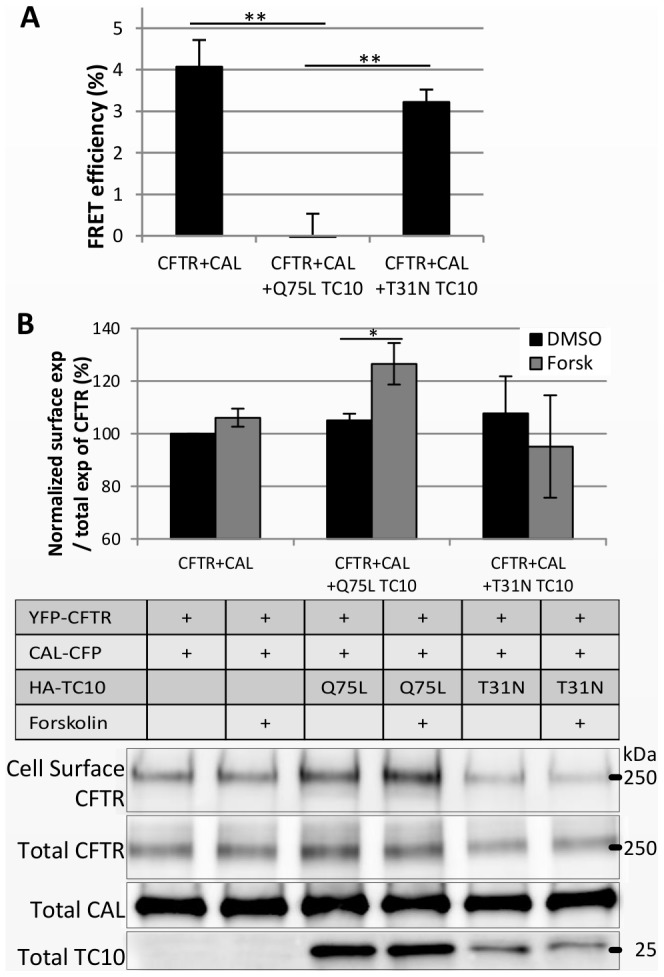
Active TC10 enhances CFTR expression at the cell surface, and this effect is impeded by highly overexpressed CAL HeLa cells were transfected with 1.5 µg of YFP-CFTR plus 0.5 µg (A) or 1.5 µg (B) of CAL-CFP expression vector without HA-TC10, with HA-Q75L TC10, or with HA-T31N TC10, as indicated.(A) The FRET efficiency of CAL and CFTR was reduced by a constitutively active mutant of TC10 (Q75L TC10) but not by a dominant-negative mutant, T31N TC10. (B) HeLa cells were treated with DMSO or 100 µM forskolin at 37°C for 30 minutes as described in the table. CFTR at the cell surface was biotinylated. The graph shows the ratio of cell surface-biontinylated CFTR to total CFTR, normalized by the ratio of the samples with YFP-CFTR and CAL-CFP treated with DMSO (%). Results are means ±SE. (In A, n = 7–13; B, n = 4) *p<0.05 and **p<0.005.